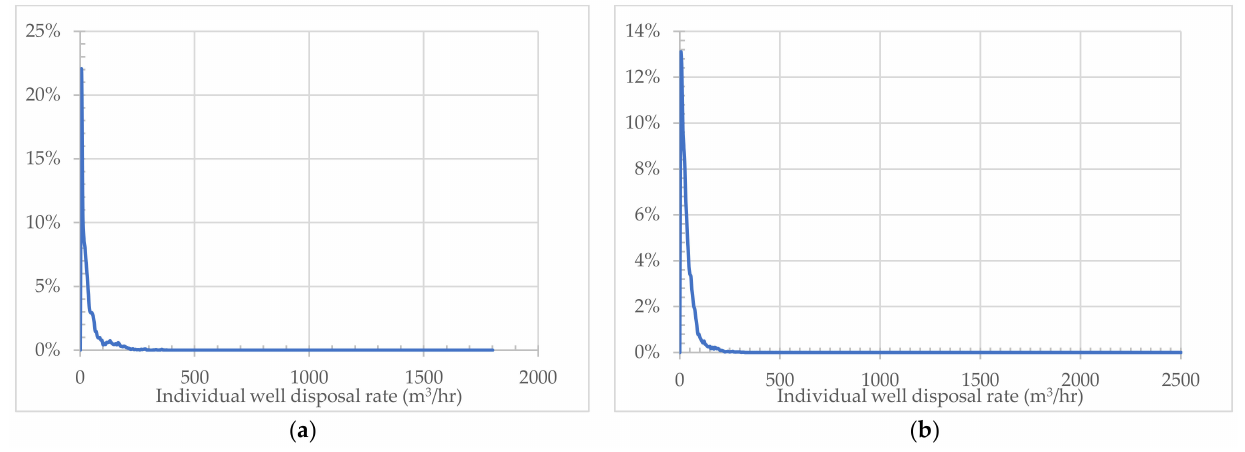
Figure A10. Historical per-well water injection rate ( X -axis) frequency ( Y -axis) distributions (January 1962–December 2022) in ( a ) the Cummings Formation; ( b ) the Dina Formation.